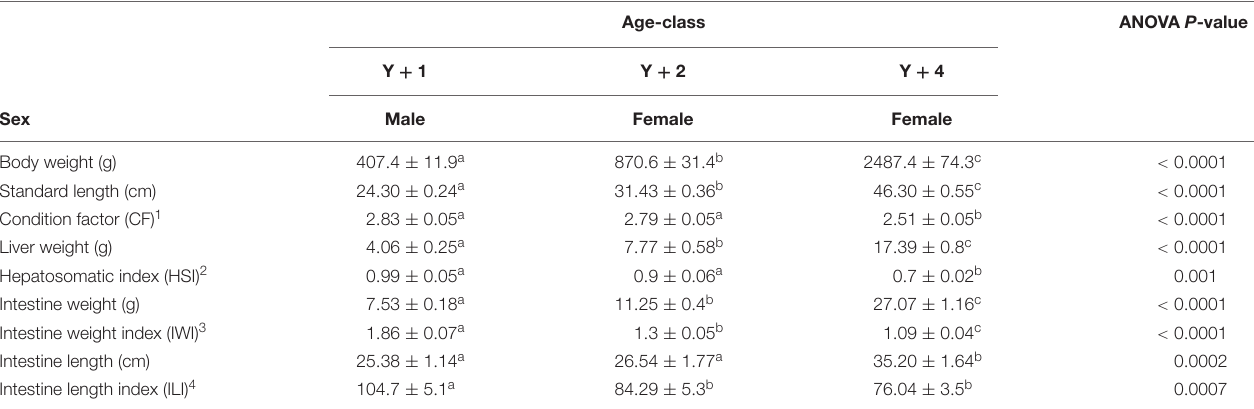
TABLE 1 | Biometric data (mean ± SEM) of 10 1-, 2-, and 4-year-old fish (Y + 1, Y + 2, and Y + 4,